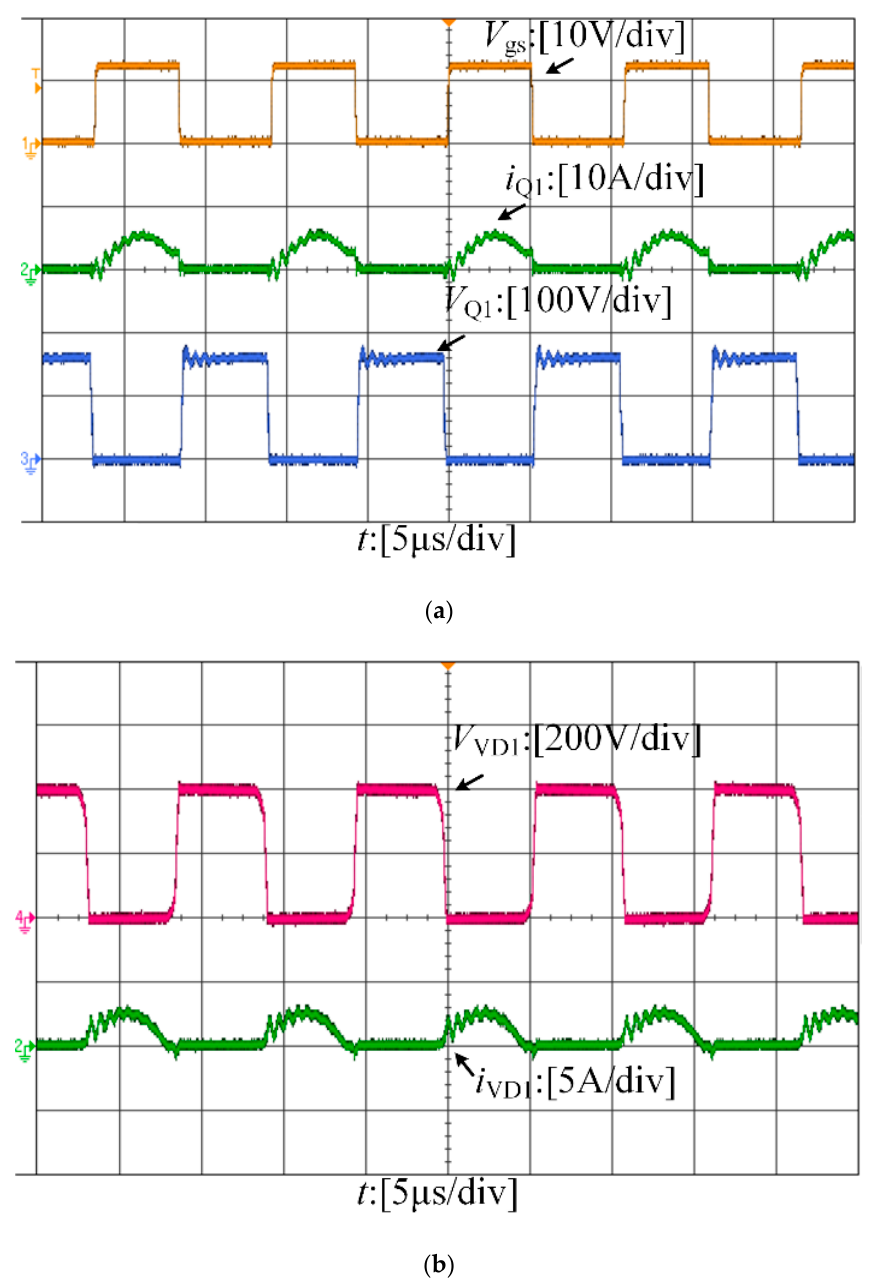
Figure 14. Experimental waveforms at point ① ’ in mode II. ( a ) Waveforms of Q 1 . ( b ) Waveforms of VD 1 .